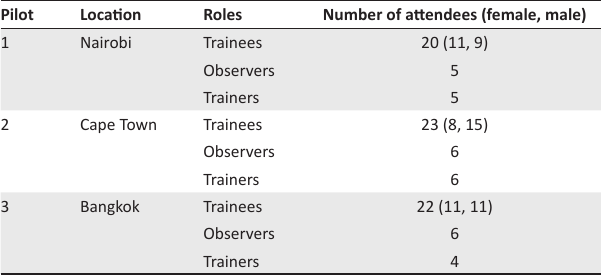
TABLE 2: Roles and number of attendees for each training.